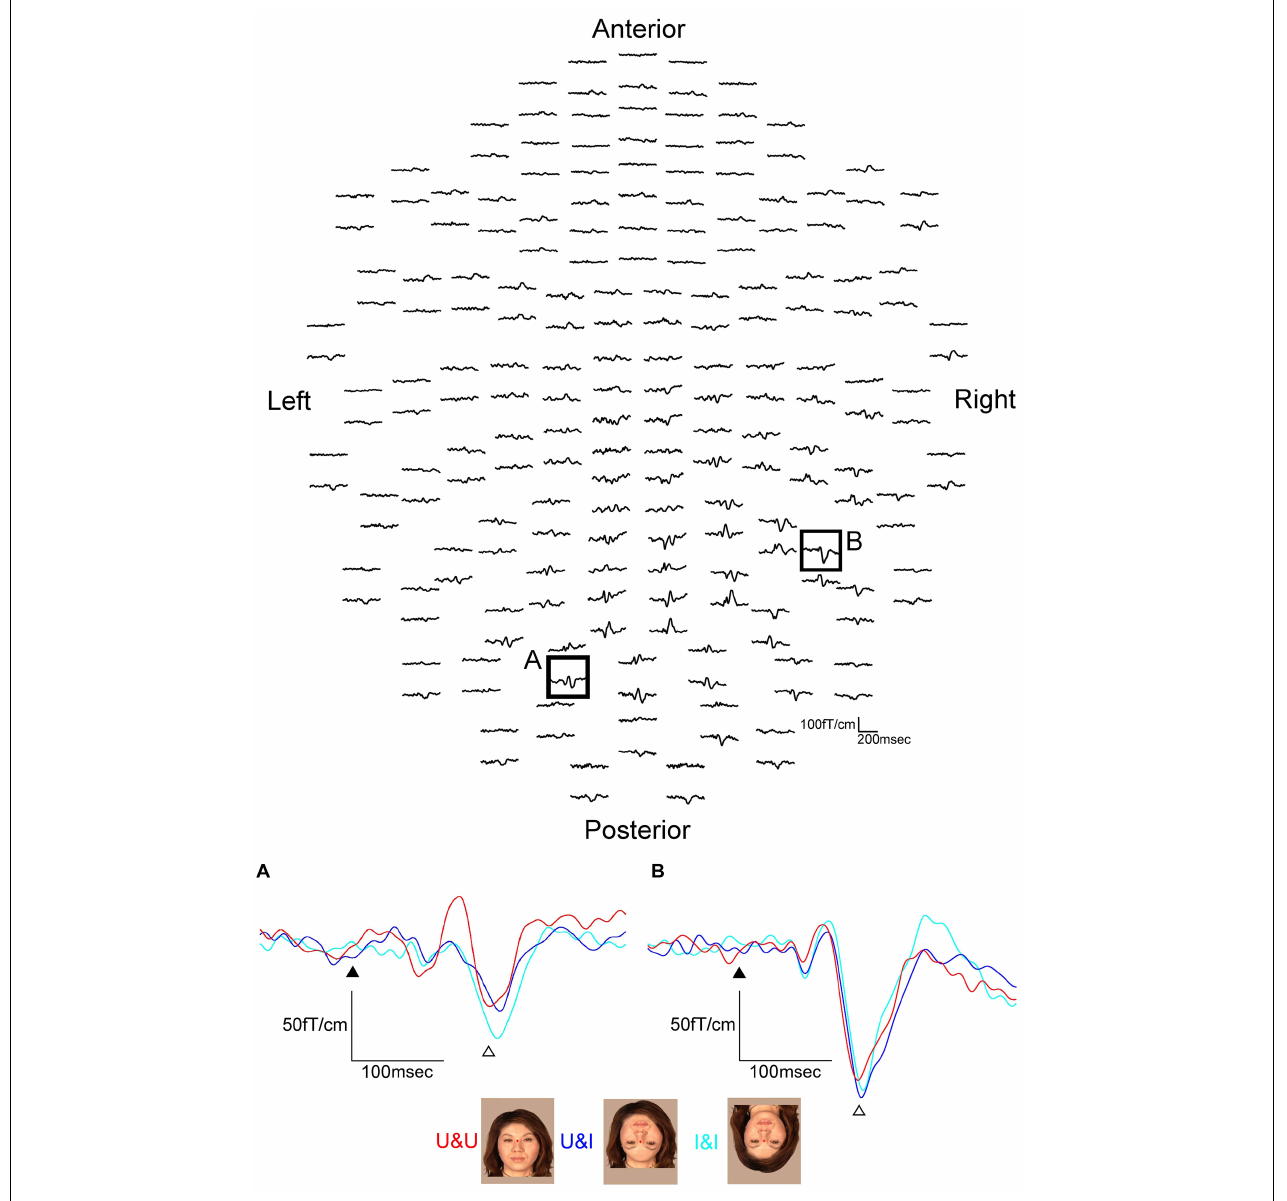
FIGURE 6 | MEG waveforms (upper) of a representative subject following stimulus onset in the U&U condition. MEG waveforms (lower) at sensors A and B in the upper image show a clear component recorded for U&U, U&I, and I&I conditions in the left and right hemispheres. (A) Representative waveforms at sensor A in the left hemisphere of the upper image. (B) Representative waveforms at sensor B in the right hemisphere of the upper image. Black arrows show the stimulus onset and white arrows show the response selected for further analysis. Responses after the stimulus onset were longer in latency for U&I and I&I than for U&U in the right hemisphere, but longer in latency for U&I than for U&U and I&I in the left hemisphere in this subject [adopted from Miki et al. (2011)]. MEG, magnetoencephalography; U&U, upright contours and upright features; U&I, upright contours and inverted features; I&I, inverted contours and inverted